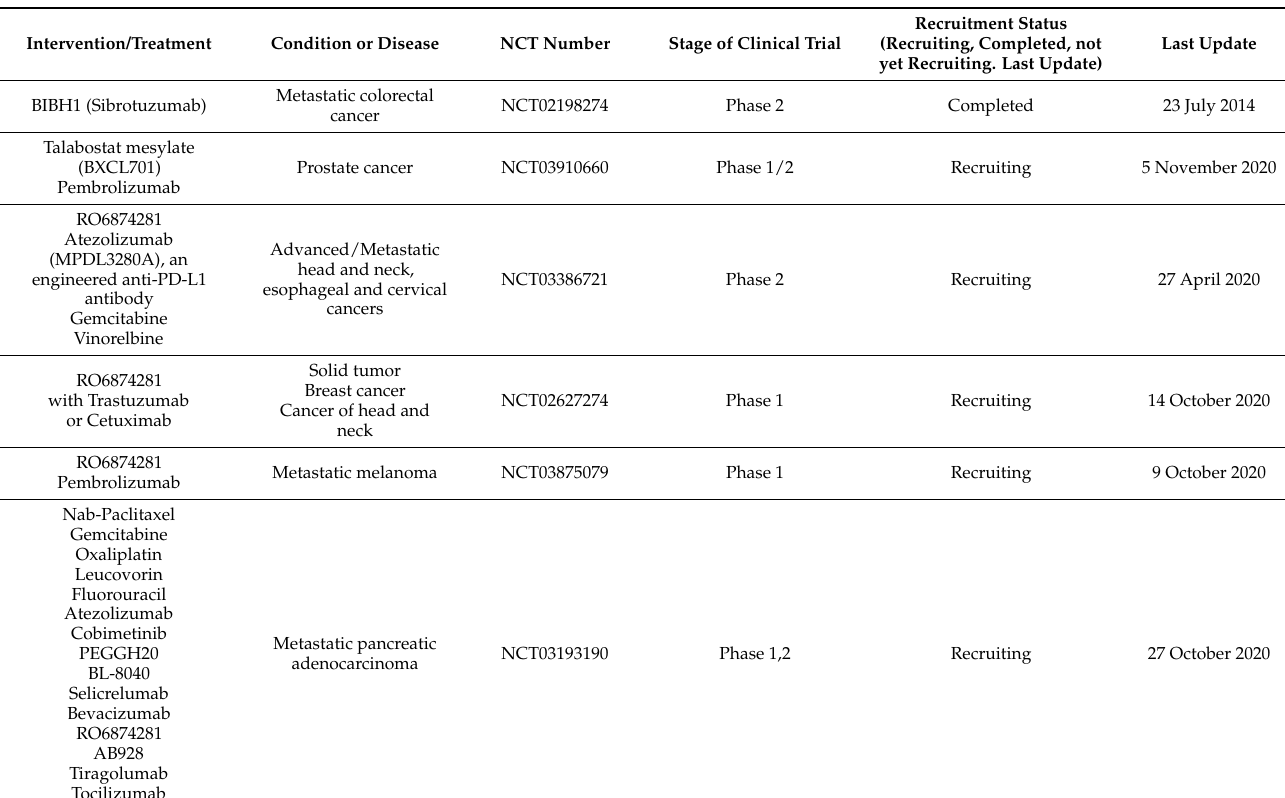
Table 1. Overview of several clinical trials targeting fibroblast activation protein, CXCL12 and CXCR4 axis, and LRRC15.